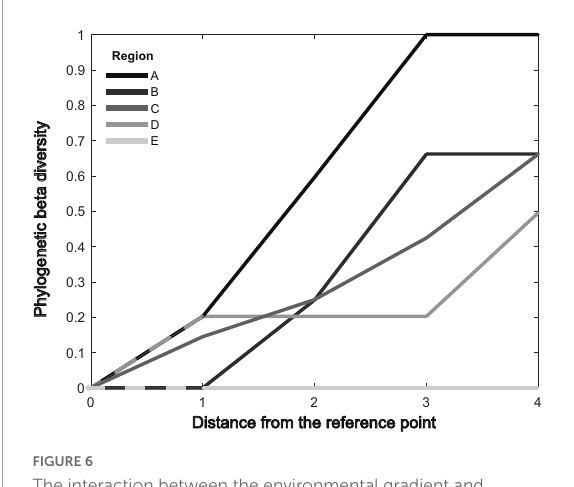
driven by differences in environmental conditions.